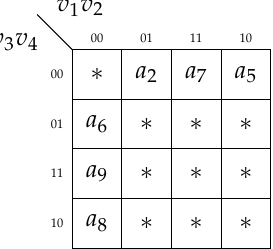
Figure 7. Partial state codes for Mealy FSM S 1